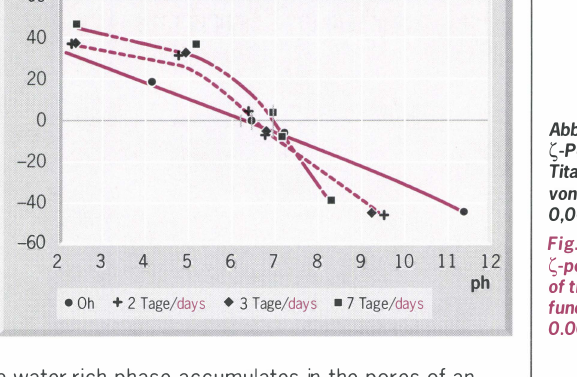
Abb. 1: (, -Potential/pH-Kurven fur TitanoxidweiB in Abhiingigkeit von der Verweilzeit in 0,001 M KCI-Liisung Fig. 1: (,-potential/pH curves of titania white as a function of time in